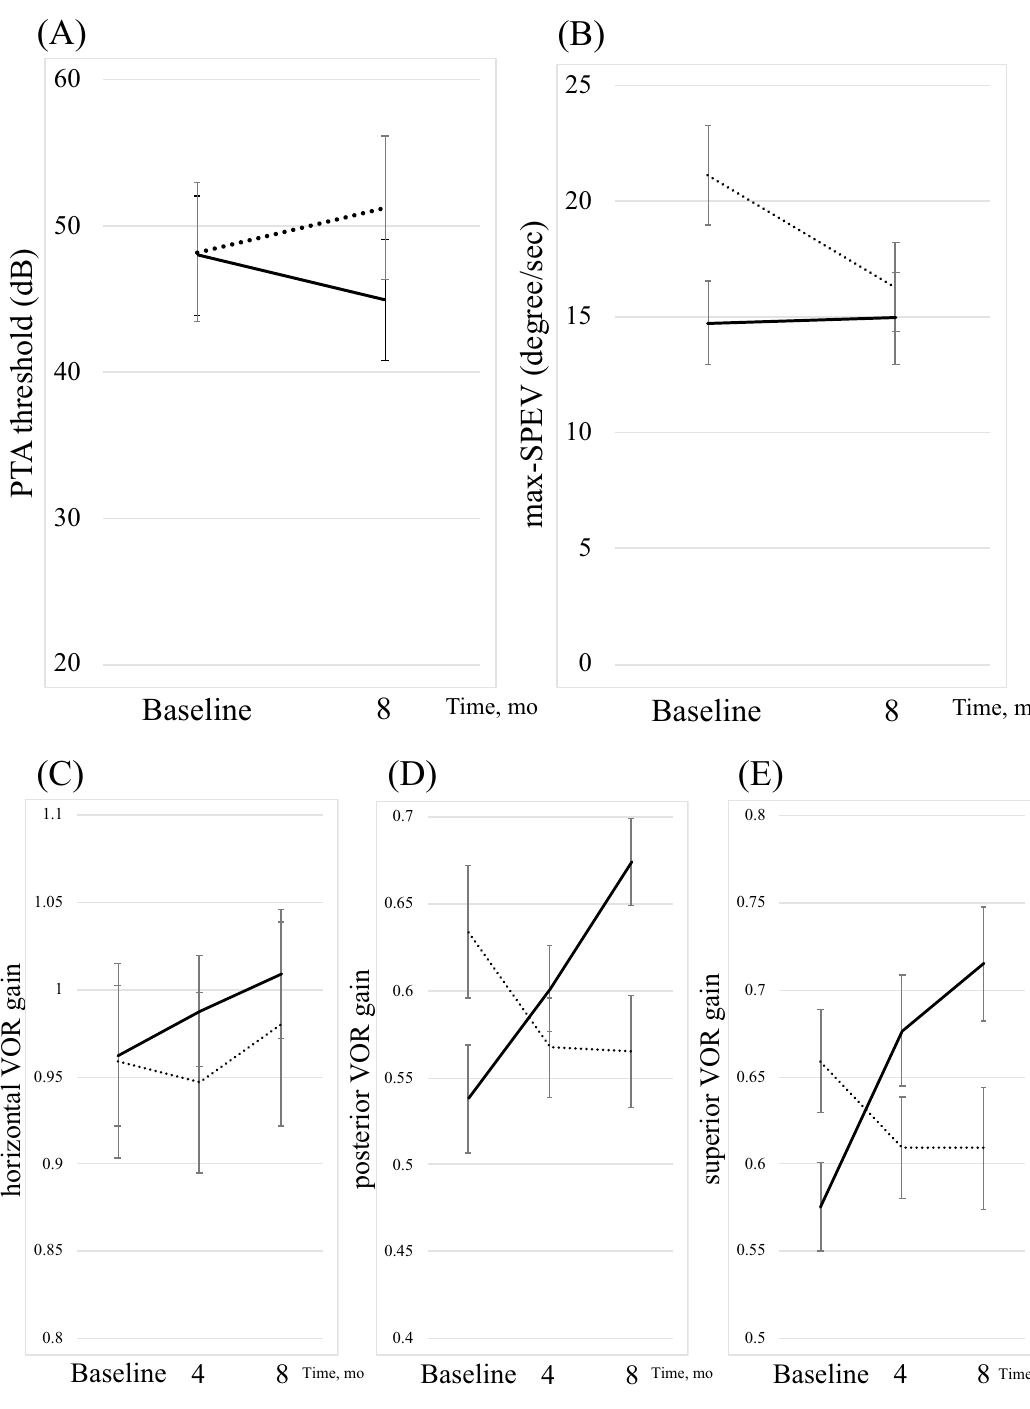
Figure 3. Serial changes in Auditory and Vestibular Function between two controlled groups. Error bars represent SE of the mean. Dotted line and solid line show Control group and PPT group, respectively. PTA indicates pure-tone audiometry, EH indicates endolymphatic hydrops and VOR, vestibulo-ocular reflex. ( A ) Change in PTA thresholds by group for the baseline month and the follow-up month. ( B ) Change in EH volume by group for the baseline month and the follow-up months. ( C ) Serial changes in horizontal VOR gain by group for the baseline month and the follow-up months. ( D ) Serial changes in posterior VOR gain by group for the baseline month and the follow-up months. ( E ) Serial changes in superior VOR gain by group for the baseline month and the follow-up